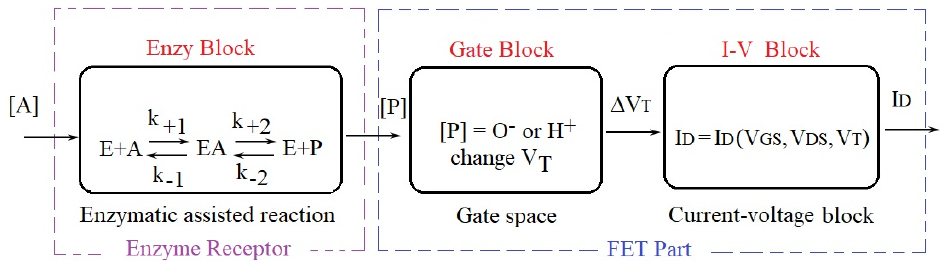
Figure 1. The blocks within a ENFET biosensor with enzyme receptors.